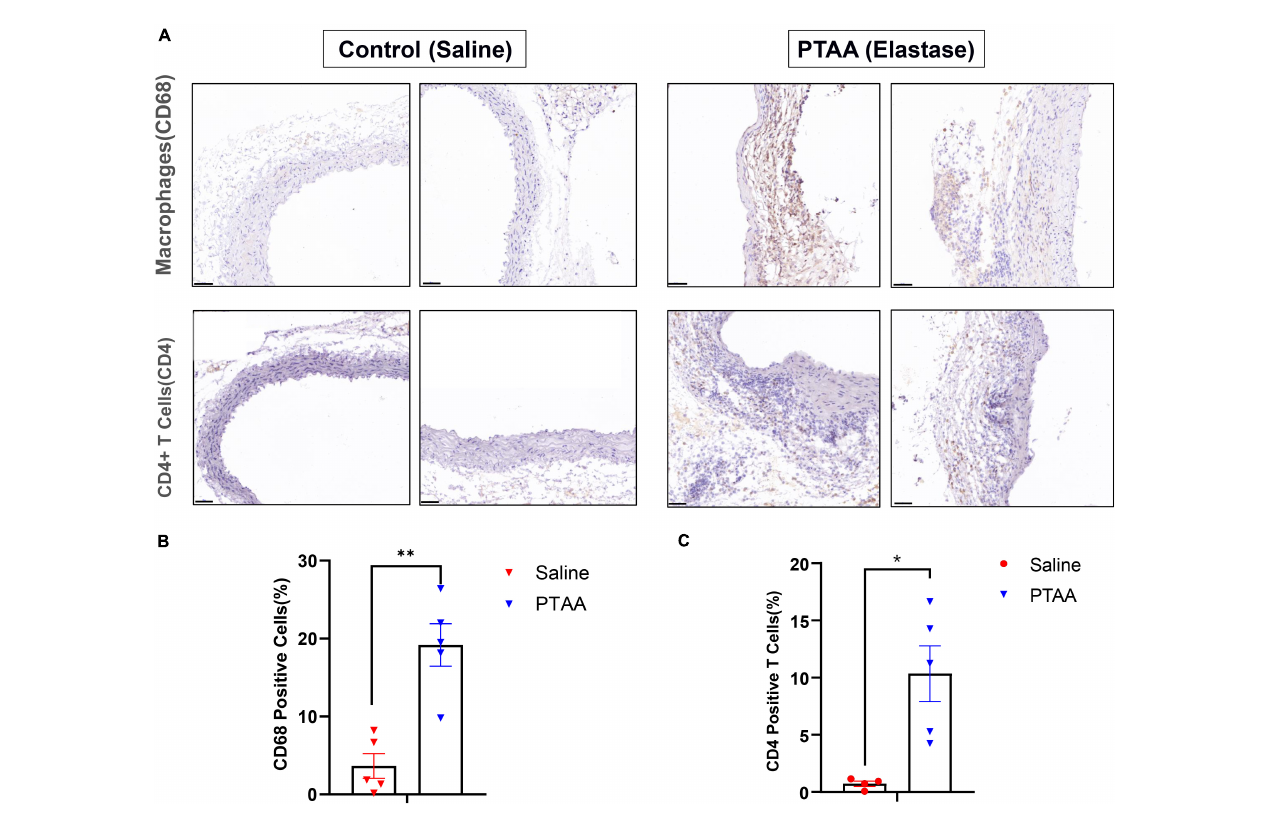
FIGURE6 Histopathological examination of Macrophages and CD4 + T cells in control (saline) and proximal thoracic aortic aneurysm (PTAA) (Elastase) tissue. (A) Representative immunohistochemistry images of CD68 and CD4 staining in both groups. Scale bar in the bottom left corner is 50 µ m. (B) Quantification of the CD68 positive macrophages in both groups. (C) Quantification of the CD4 + T Cells in both groups. Mean ± s.e.m; two-tailed Mann–Whitney tests, * P < 0.05 and ** P <